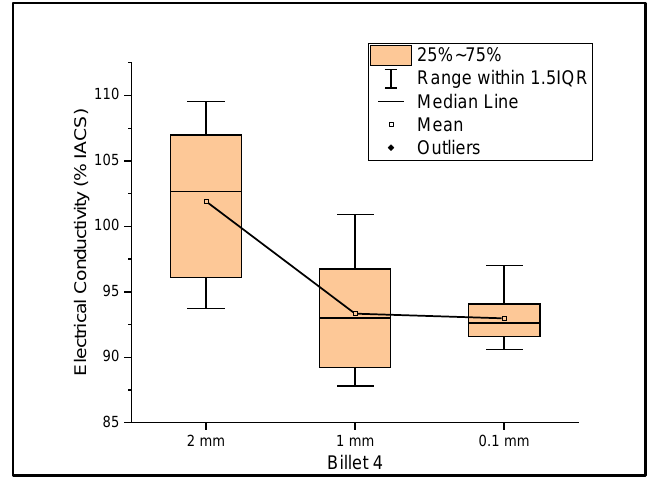
Figure 4. The electrical conductivity of Billet 4 at different cross-sectional sizes.